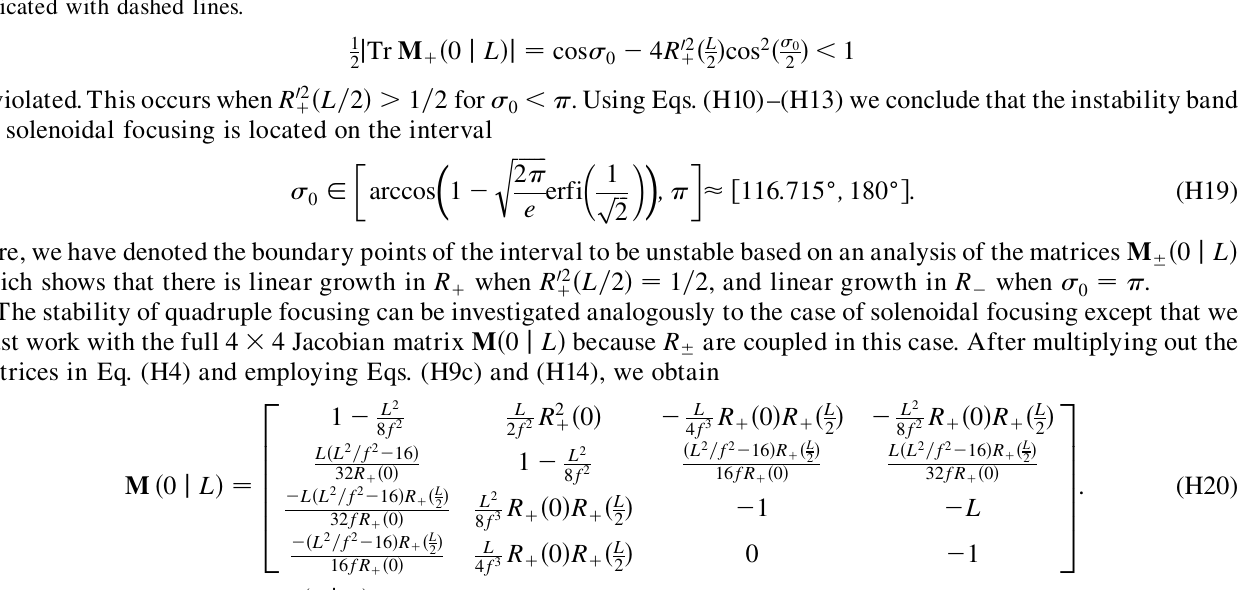
FIG. 25. (Color) Phase advance ( (cid:24) (cid:16) ) and growth factors ( (cid:6) (cid:16) ) for the breathing and quadrupole modes versus (cid:24) lens solenoidal focusing channel and a fully depressed beam with (cid:24) (cid:1) 0 . Continuous focusing model predictions for (cid:24) (cid:16) are indicated with dashed